Question: What visual encoding does this figure use to show its data?
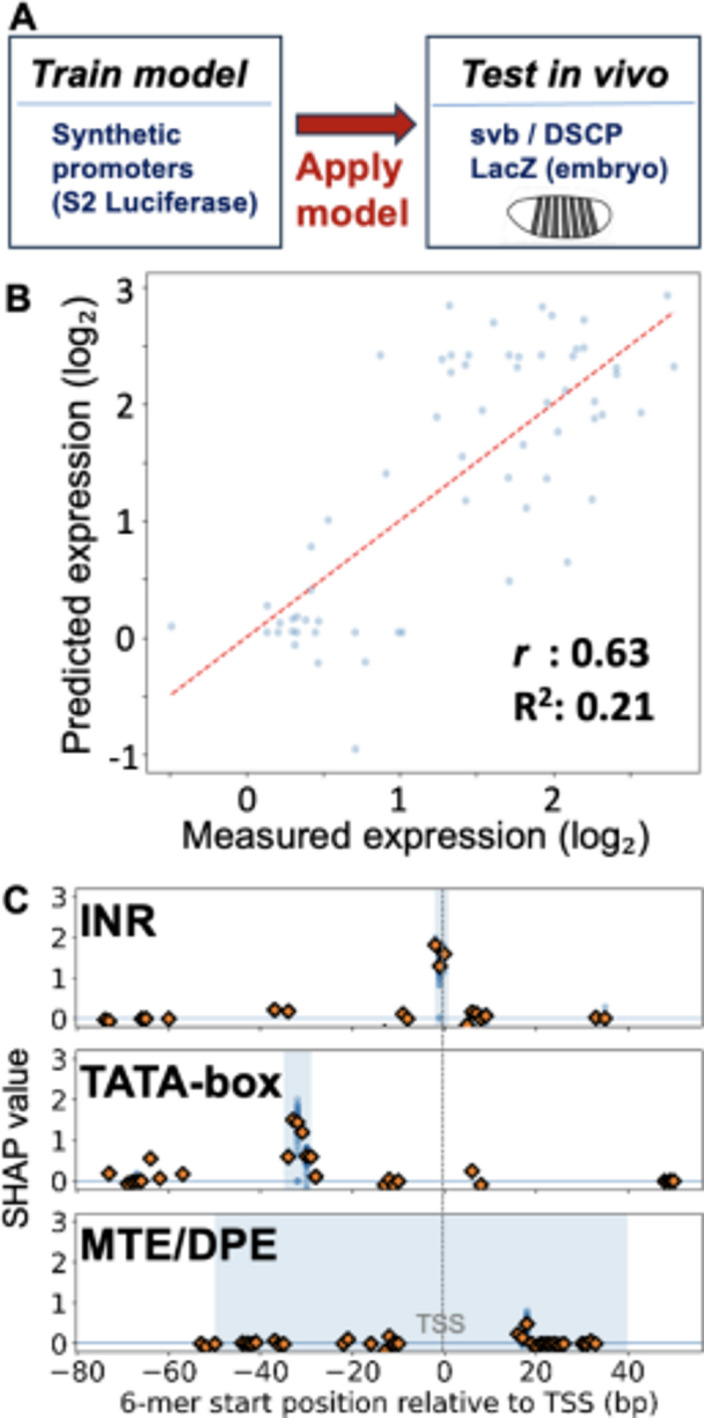
Answer: scatter